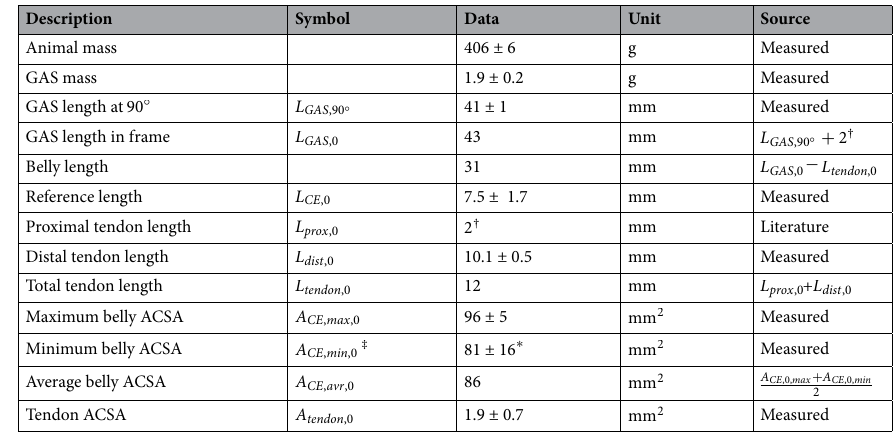
Table 1. Anatomical data given as the mean value ± standard deviation. We calculated the anatomical cross- sectional area (ACSA) right before TD by assuming that the belly had the geometrical shape of a half-ellipse. † The 2 mm added to measured L ‡ A CE , min ,0 was measured GAS ,90 ◦ ≈ L opt were inferred from literature 47,48 . 8 mm distal, along the muscle belly, to where A CE ,0, max was measured, both in passive muscle state. ∗ The ≈ relatively large SD in A CE ,0, min is due to one outlier geometry.